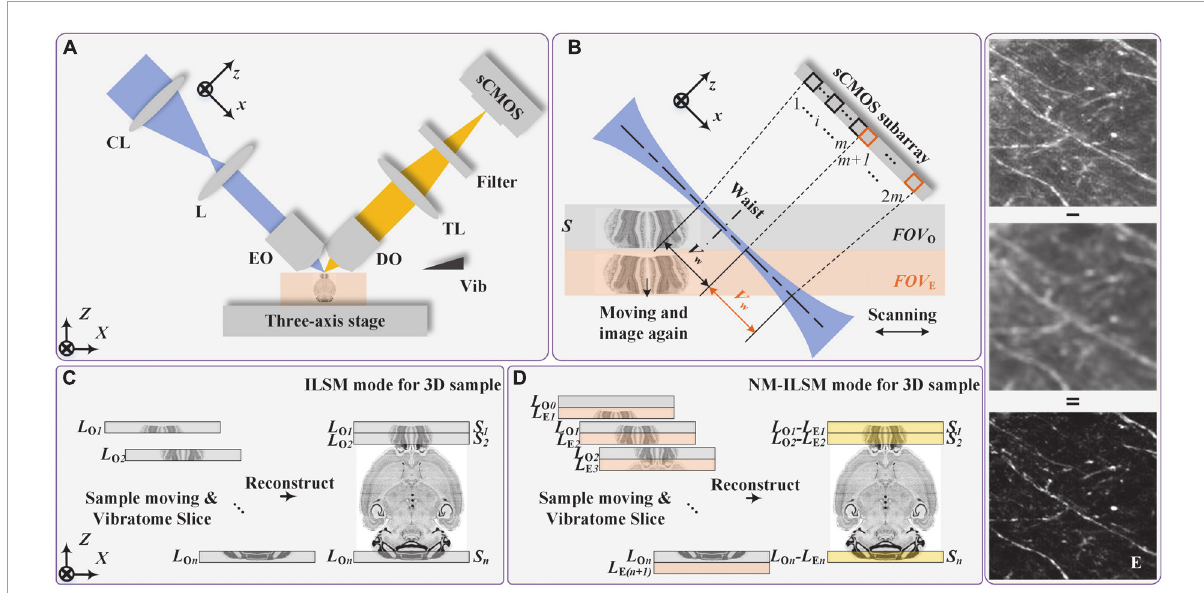
FIGURE1 Imaging principle of NM-ILSM. (A) Schematic diagram of the system configuration. (B) ILSM mode: imaging the sample S with FOV O . NM-ILSM mode: imaging the sample S n again after ILSM mode with FOV E . CL, cylindrical lens; L, lens; EO, excitation objective; DO, detection objective; TL, tube lens; sCMOS, scientific complementary metal–oxide–semiconductor detector. (C,D) Data acquisition flow of large-volume 3D imaging by the updated system combined with a customized vibratome in ILSM and NM-ILSM modes, respectively. (E) A typical example showing maximum intensity projections (MIP) with a 20- µ m-thickness in the central and extended FOVs, and their NM-ILSM reconstructed